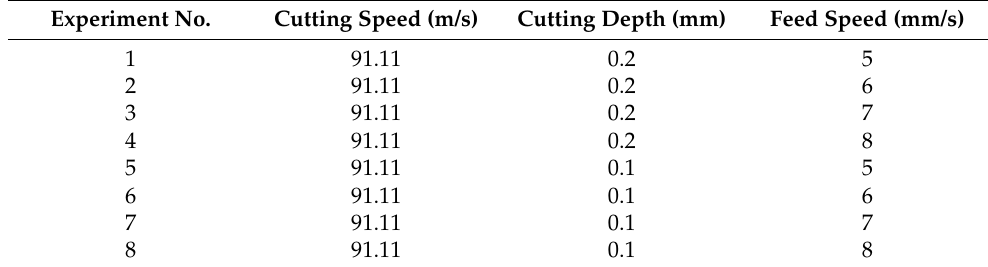
Table 6. Process parameters of validation experiment. Experiment No.